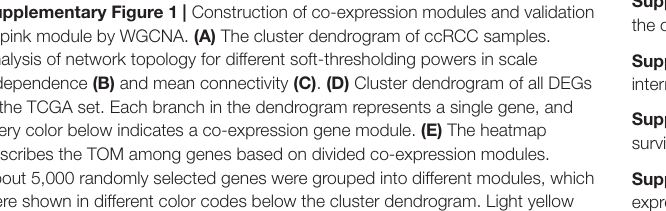
Supplementary Table 2 | Functional enrichment analyses of the genes in the distant metastasis-related pink module. Supplementary Table 3 | The combined score among nodes of PPI network in the co-expression pink module. Supplementary Table 4 | Hub mRNAs were screened by WGCNA, PPI, TCGA internal test, GEPIA external validation, and GEO external validation. Supplementary Table 5 | Screening for key miRNAs using correlation analysis, survival analysis, and expression analyses. Supplementary Table 6 | Screening for key lncRNAs using correlation analysis, expression analyses, and survival